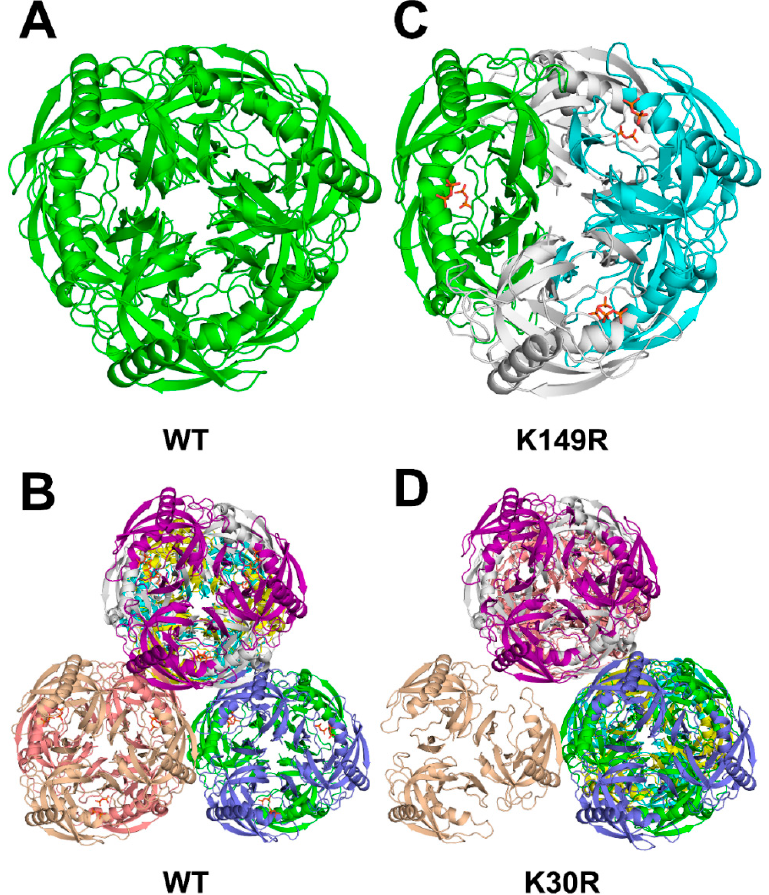
Figure 3. Top view of crystal packings of AbPPase. ( A ) Crystal structure of AbPPase without PPi, in which there is only one monomer in the asymmetric unit. Only one type of AbPPase hexamers was assembled. ( B ) Crystal structure of AbPPase with PPi, in which there are eight AbPPase monomers in the asymmetric unit. Eight different trimers could assemble four different types of AbPPase hexamers. ( C ) Crystal structure (K149R) of AbPPase with PPi in which there are three AbPPase monomers form a trimer in the asymmetric unit. One type of AbPPase hexamers was assembled. ( D ) Crystal structure (K30R) of AbPPase without PPi, in which there are eight AbPPase monomers in the asymmetric unit, and could assemble four different types of AbPPase hexamers and one type of trimer. 2.2. Variable PPi Binding Snapshots in WT AbPPase Catalytic Center The resolution of Structure 2 is 1.86 Å, which is less than inter-residue distances, divalent cations, and water molecules within the catalytic center. Therefore, the electron densities of the groups within the catalytic centers of the eight AbPPase monomers are sufficiently resolved to determine bonding networks with PPi, accurately. By carefully analyzing Structure 2, we found that the electron density of eight AbPPase catalytic centers is different (Figure 4). Each hexameric unit has two trimeric layers with different catalytic constants. AbPPase monomers in one trimer exist in the same state, indicating that two AbPPase trimers in the hexameric enzyme could be in two different states. Monomer A and B, C and D, E and F, and G and H assemble into the AbPPase hexamer 1, 2, 3, and 4 (Figure 4,S2). In monomer A, the electron density of M3 overlaps with O1 and O4 atoms of PPi, and a water molecule (W2) overlaps with O3 of PPi. The distance between W2 and Pi is only 3.3 Å, which is shorter than the distance between W1 and Pi (i.e., 4.1 Å). In monomer B, the electron density indicates that the PPi O4 atom could form a bond with the Lys143 N ζ group. In addition, the electron density of M2, a water molecule (W3) and the PPi O2 atom overlap. In monomer C, the electron densities from PPi O4